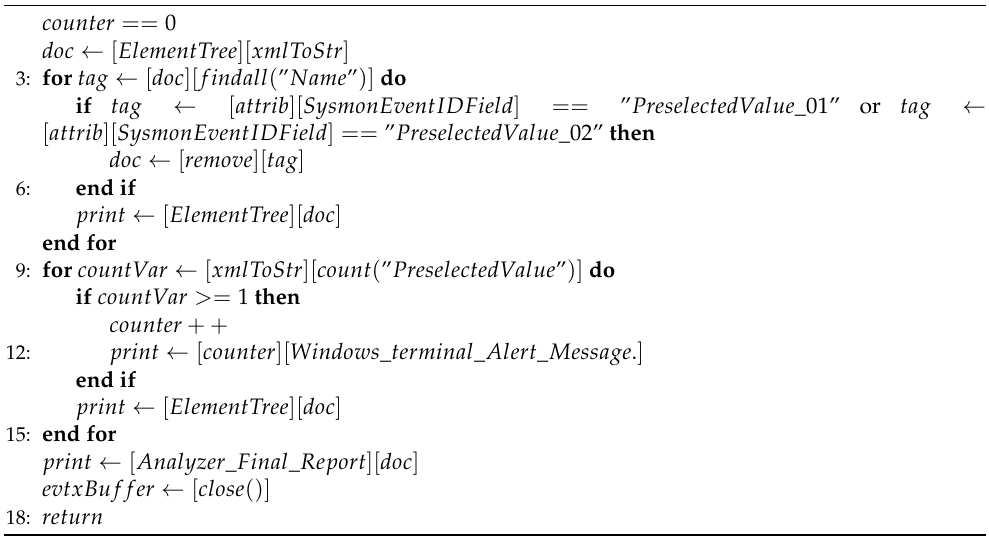
Algorithm 3 PeX’s xml parsing and LM identification